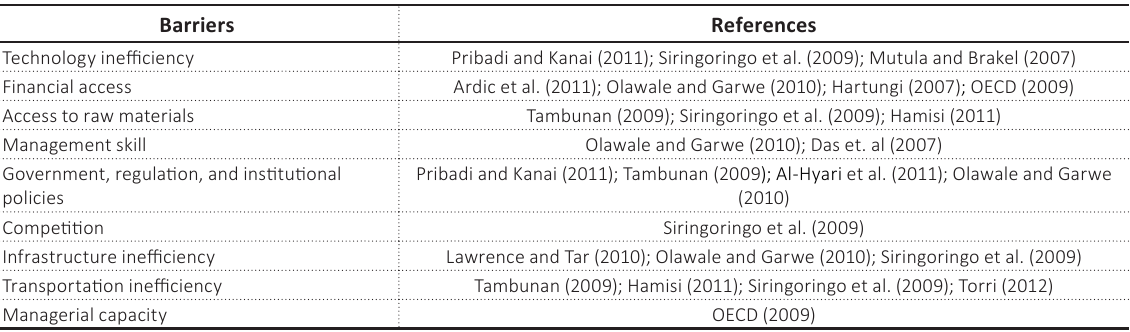
Table 1. Conceptual literature review